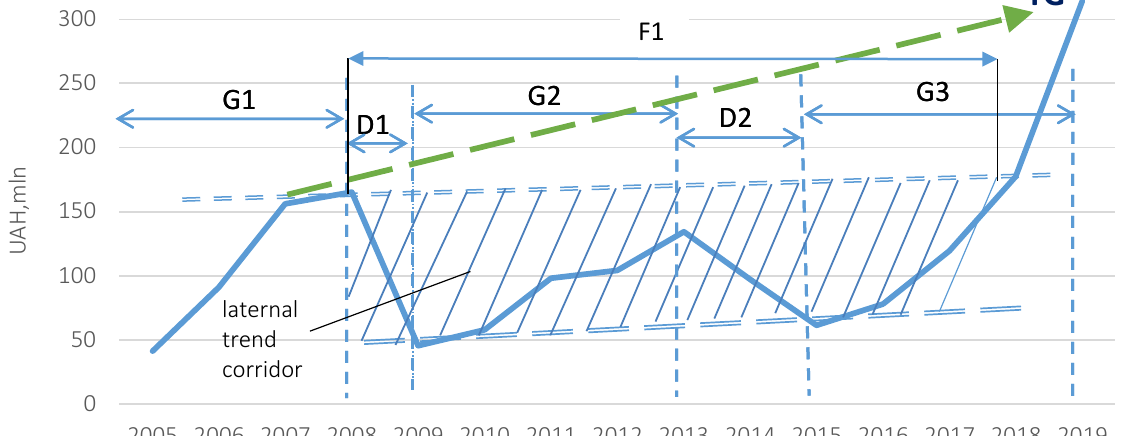
Figure 1. Growth trend of the Ukrainian retail lending market for the period 2005–2019